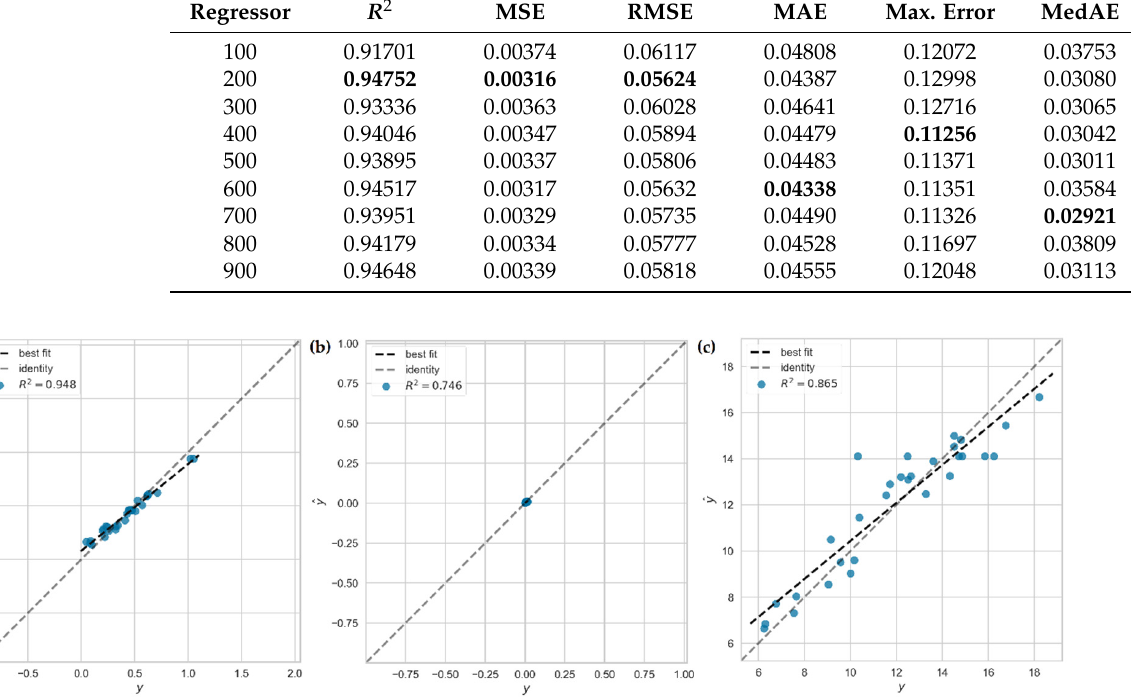
Figure 4. Experimental versus random forest regression predicted ( a ) MRR ( b ) EWR ( c ) SR.